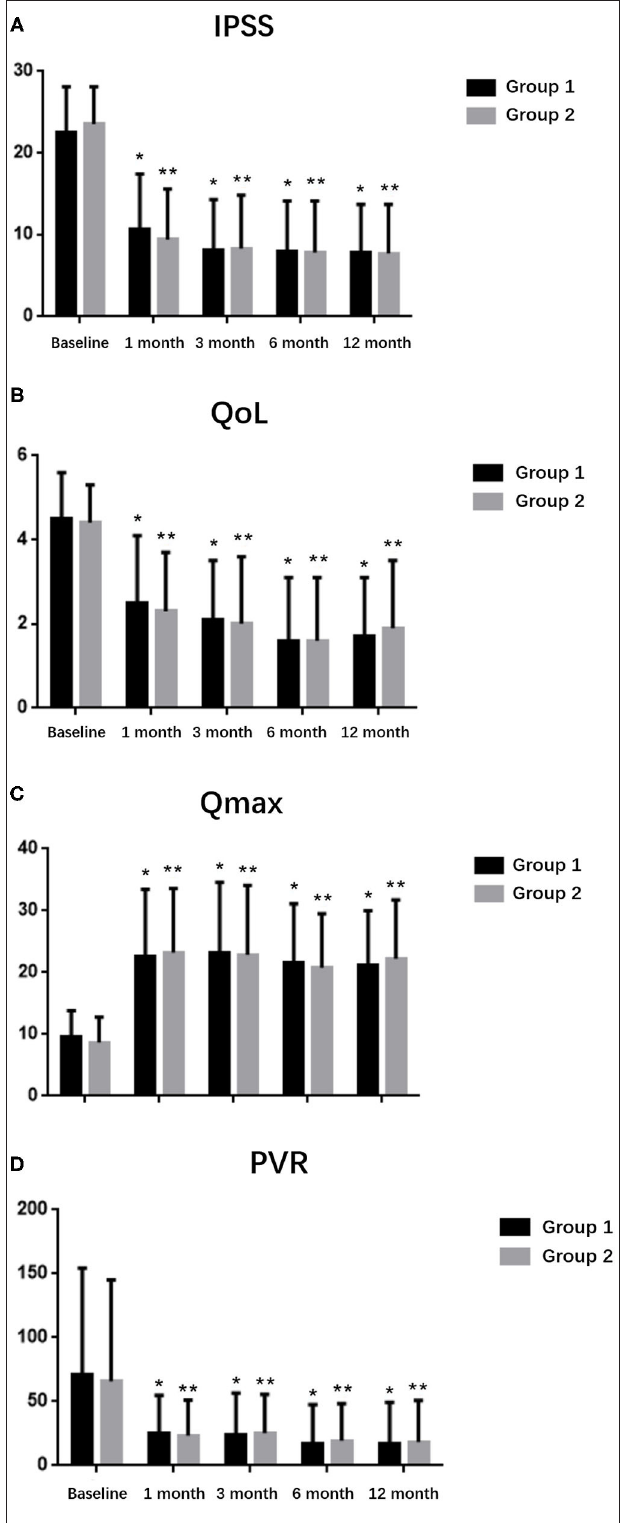
FIGURE 2 | Follow-up data for up to 12 months in the two groups. (A) IPSS, (B) QoL, (C) Qmax, and (D) PVR. * P < 0.05 and ** P < 0.05 compared with baseline